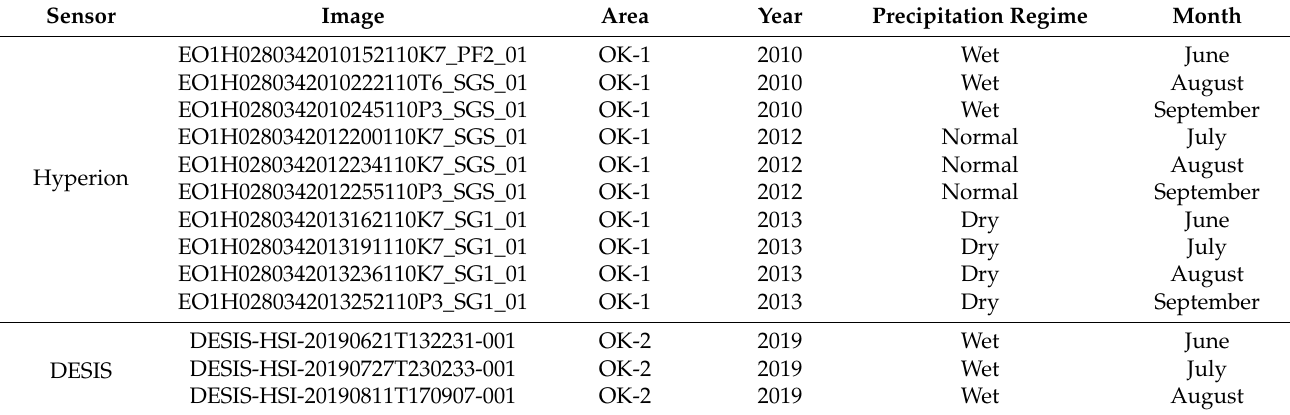
Figure 1. Hyperion and DESIS images. Hyperion and DESIS images used over Ponca City, Oklahoma, USA. CDL data source: [50]. Table 2. Hyperion and DESIS images used. Timing of collected Hyperion and DESIS imagery and precipitation regime. All images contain samples of corn, soybean, and winter wheat